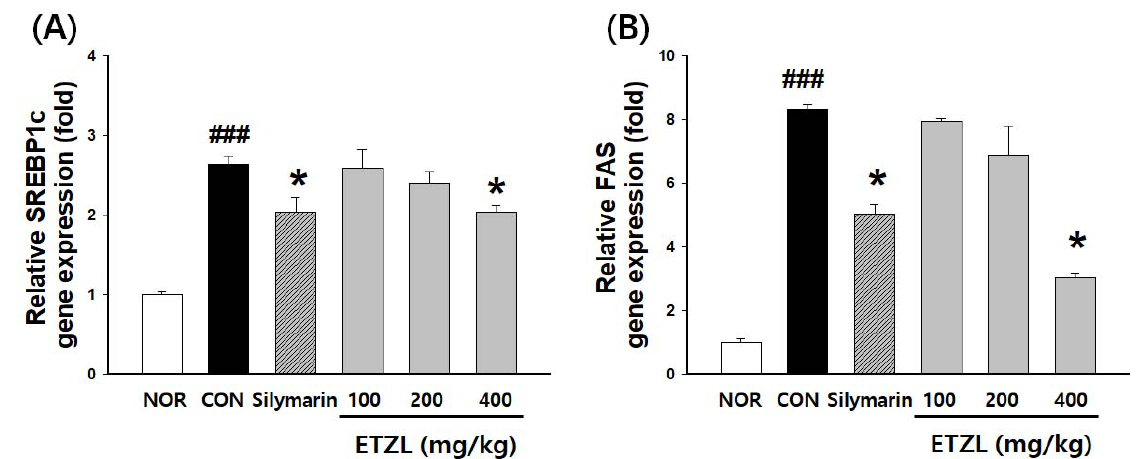
Figure 8. Effects of ETZL on mRNA of lipogenesis related genes in liver tissue of binge rats. mRNA expression level of: ( A ) SREBP-1c, ( B ) FAS in the liver. SD rats (male, 7 weeks, n = 3 rats per group) were used. Rats in the alcohol group were administered 5 g/kg alcohol intragastrically every 12 h for a total of 3 doses. ETZL was orally administered at 100 , 200, or 400 mg/kg, 30 min before alcohol administration. Control animals received an identical volume of the vehicle. The positive control was gavaged with silymarin (50 mg/kg). Then, lipogenesis-related genes were measured. Values are expressed as mean ± SD. Significant differences compared with the normal (NOR) are indicated by ### p < 0.001. Significant differences compared with the control (CON) are indicated by * p <